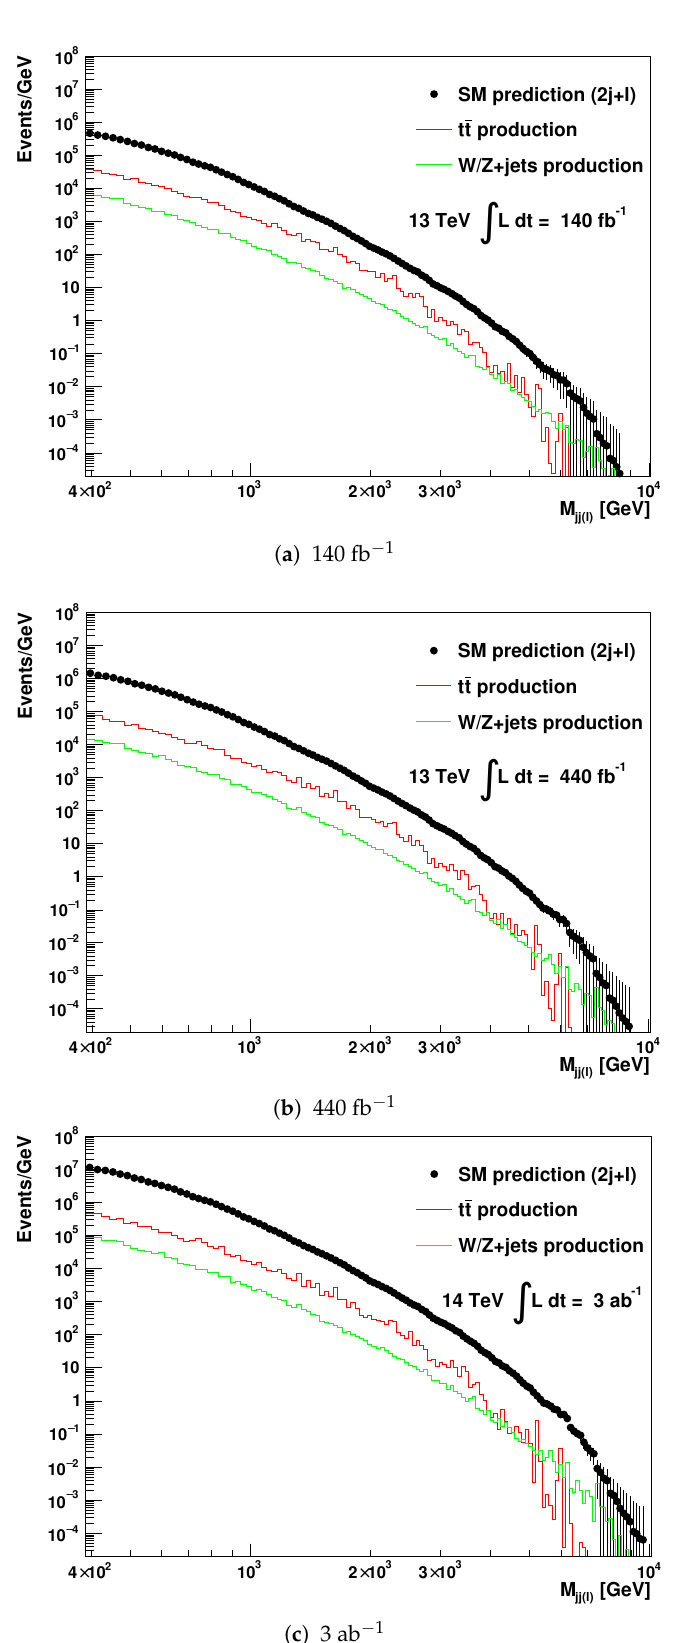
Figure 9. Expectations for m jjl invariant mass distributions for 140 fb − 1 , 440 fb − 1 and 3 ab − 1 (14 TeV) using the PYTHIA 8 generator for events with at least one isolated lepton with p l tributions from W / Z / H 0 -boson processes and top-quark processes are shown separately (without stacking the